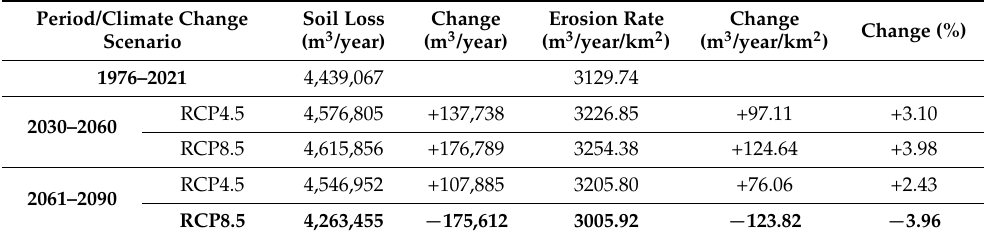
Table 8. Annual soil loss and erosion rate in the current and projected